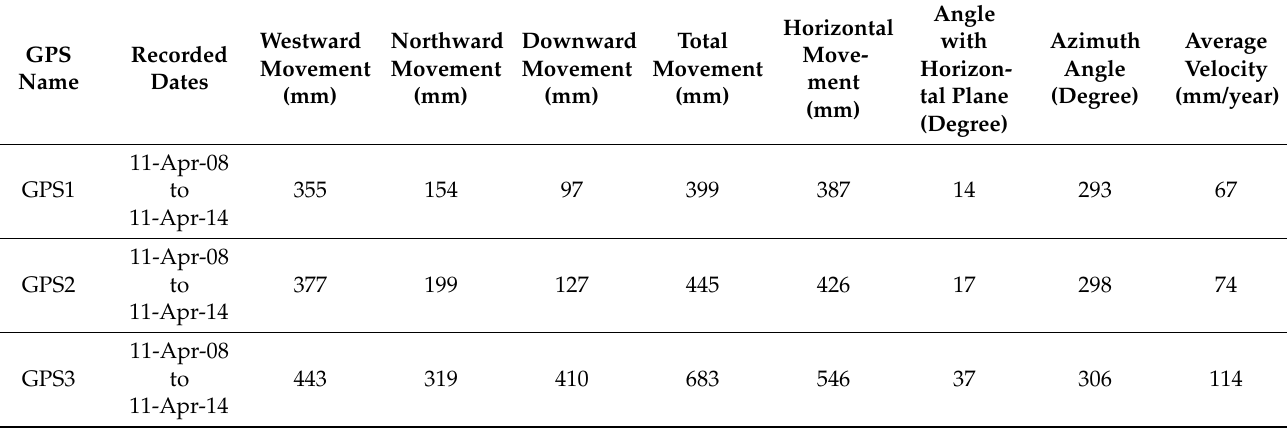
Table 4. Movement Records of Installed GPS on Ripley